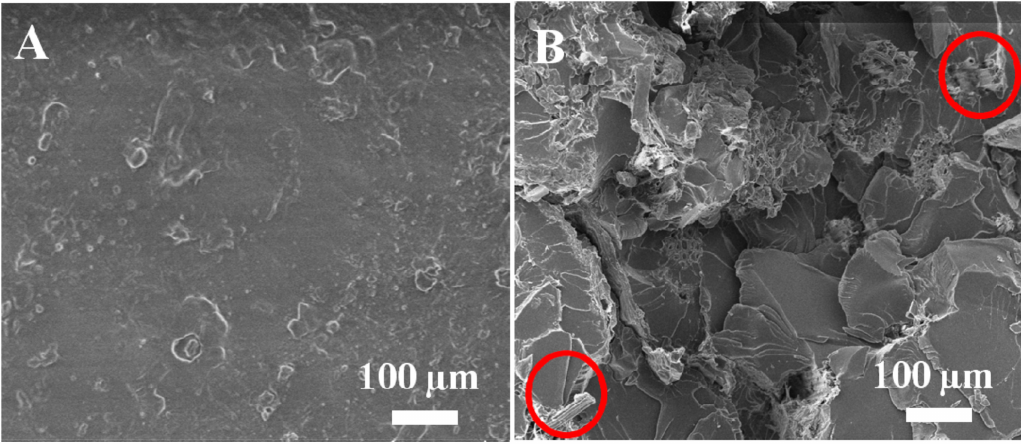
Figure 13. SEM images of pure PLA ( A ) and PLA / abutilon fiber ( B